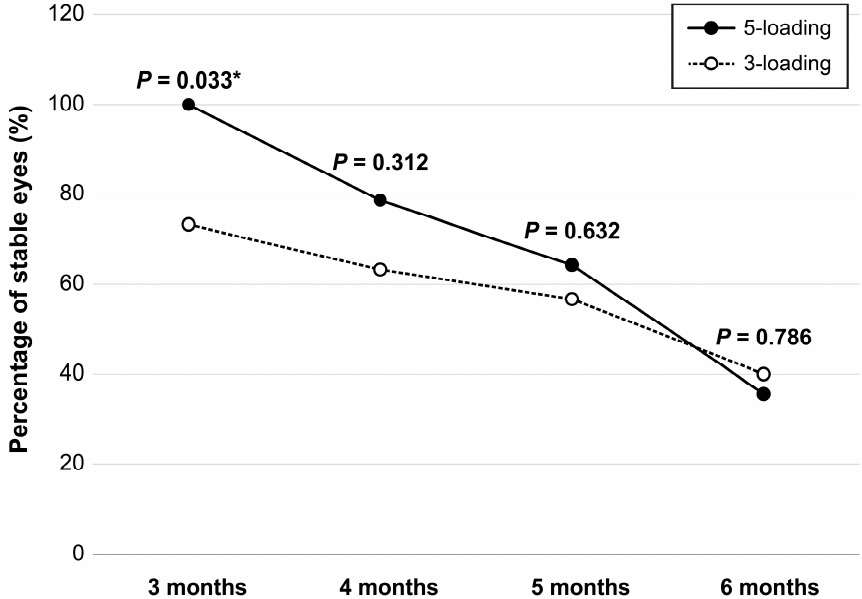
Figure 2. Proportion of stable eyes with DME following IVA loading. Follow-up period is presented as months after the last loading injection. * p < 0.05 by chi-square test. Table 2. Clinical outcomes through 6 months of follow-up.